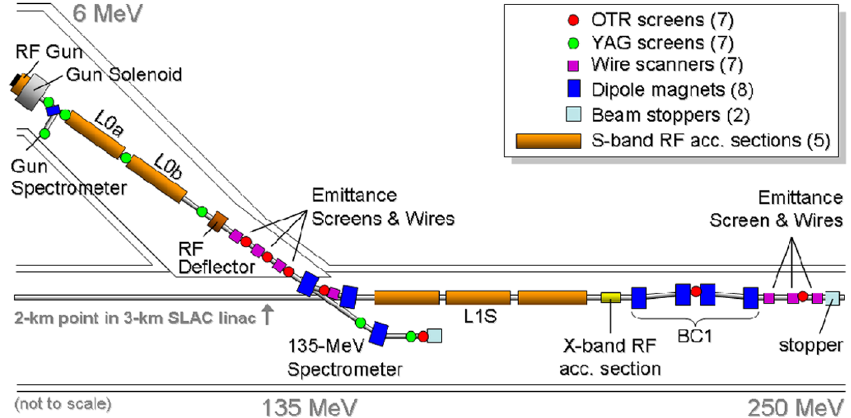
FIG. 1. (Color) The LCLS injector, from gun through first bunch compressor (BC1), with gun located in a separate, off-axis enclosure at the 2 = 3 -point along the SLAC